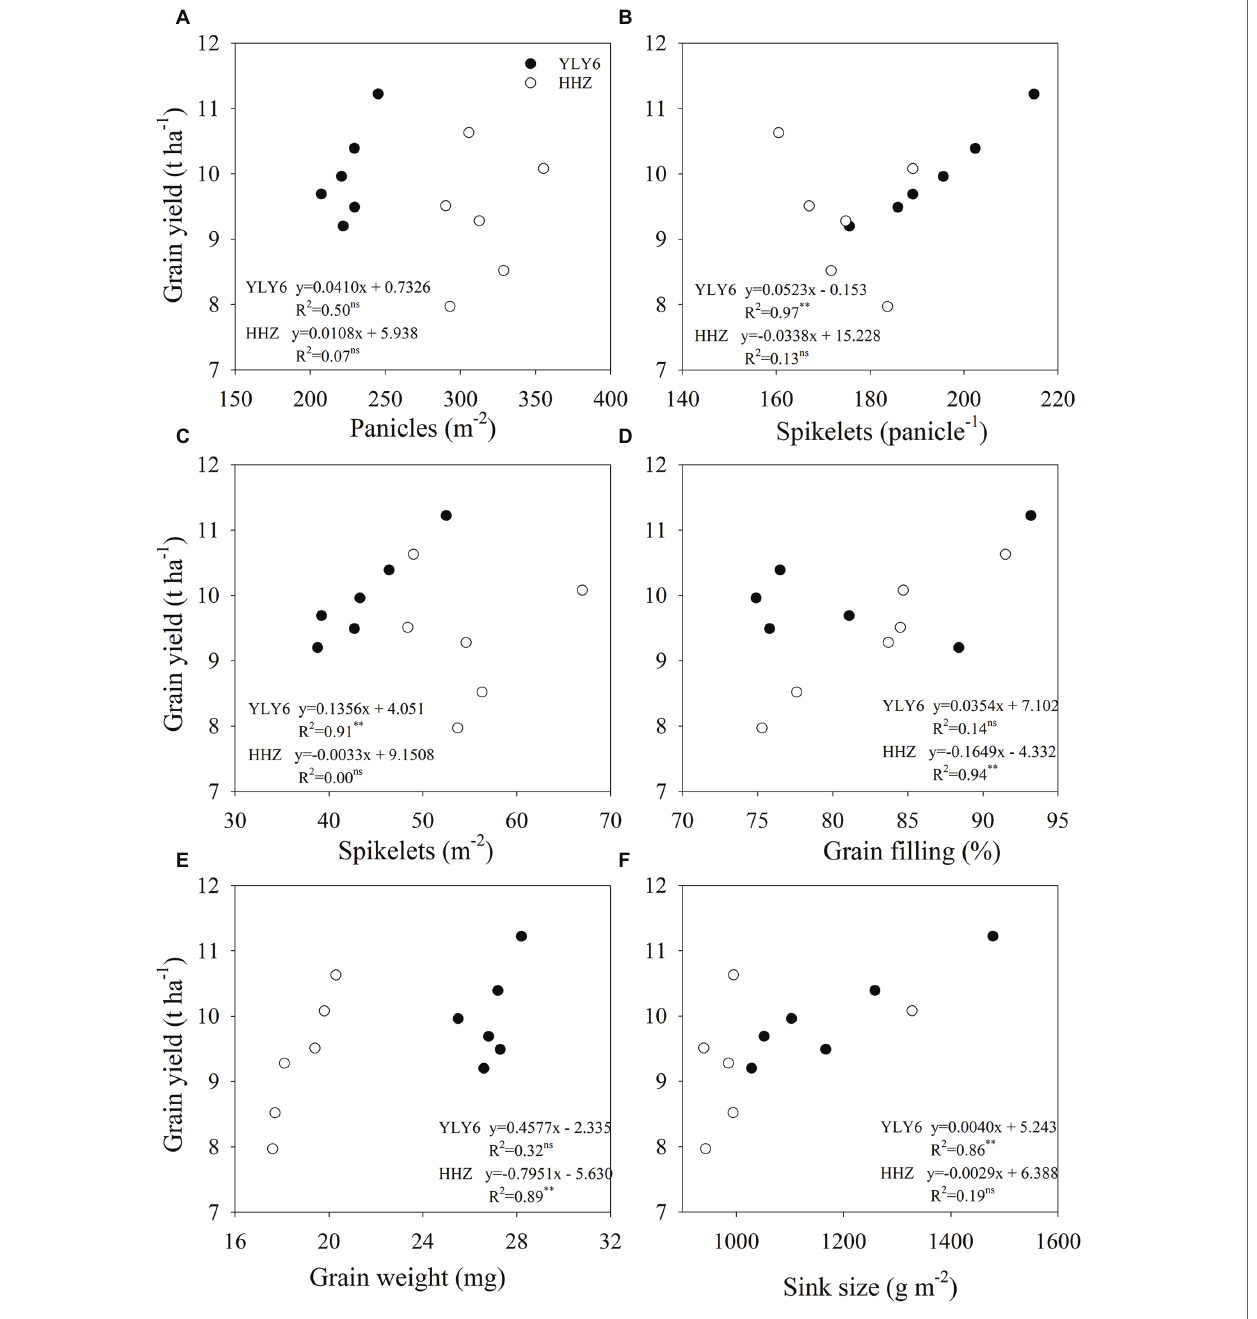
FIGURE 3 | Correlations of yield components (panicles m − 2 , spikelets per panicle, spikelets m − 2 , grain filling percentage, grain weight, and sink size) with grain yield (A–F) for YLY6 and HHZ ( n = 6), respectively. ns and ∗ ∗ are not statistically significant at the p ≤ 0.05 and significant at the p ≤ 0.01 probability level according to the Student’s t test,